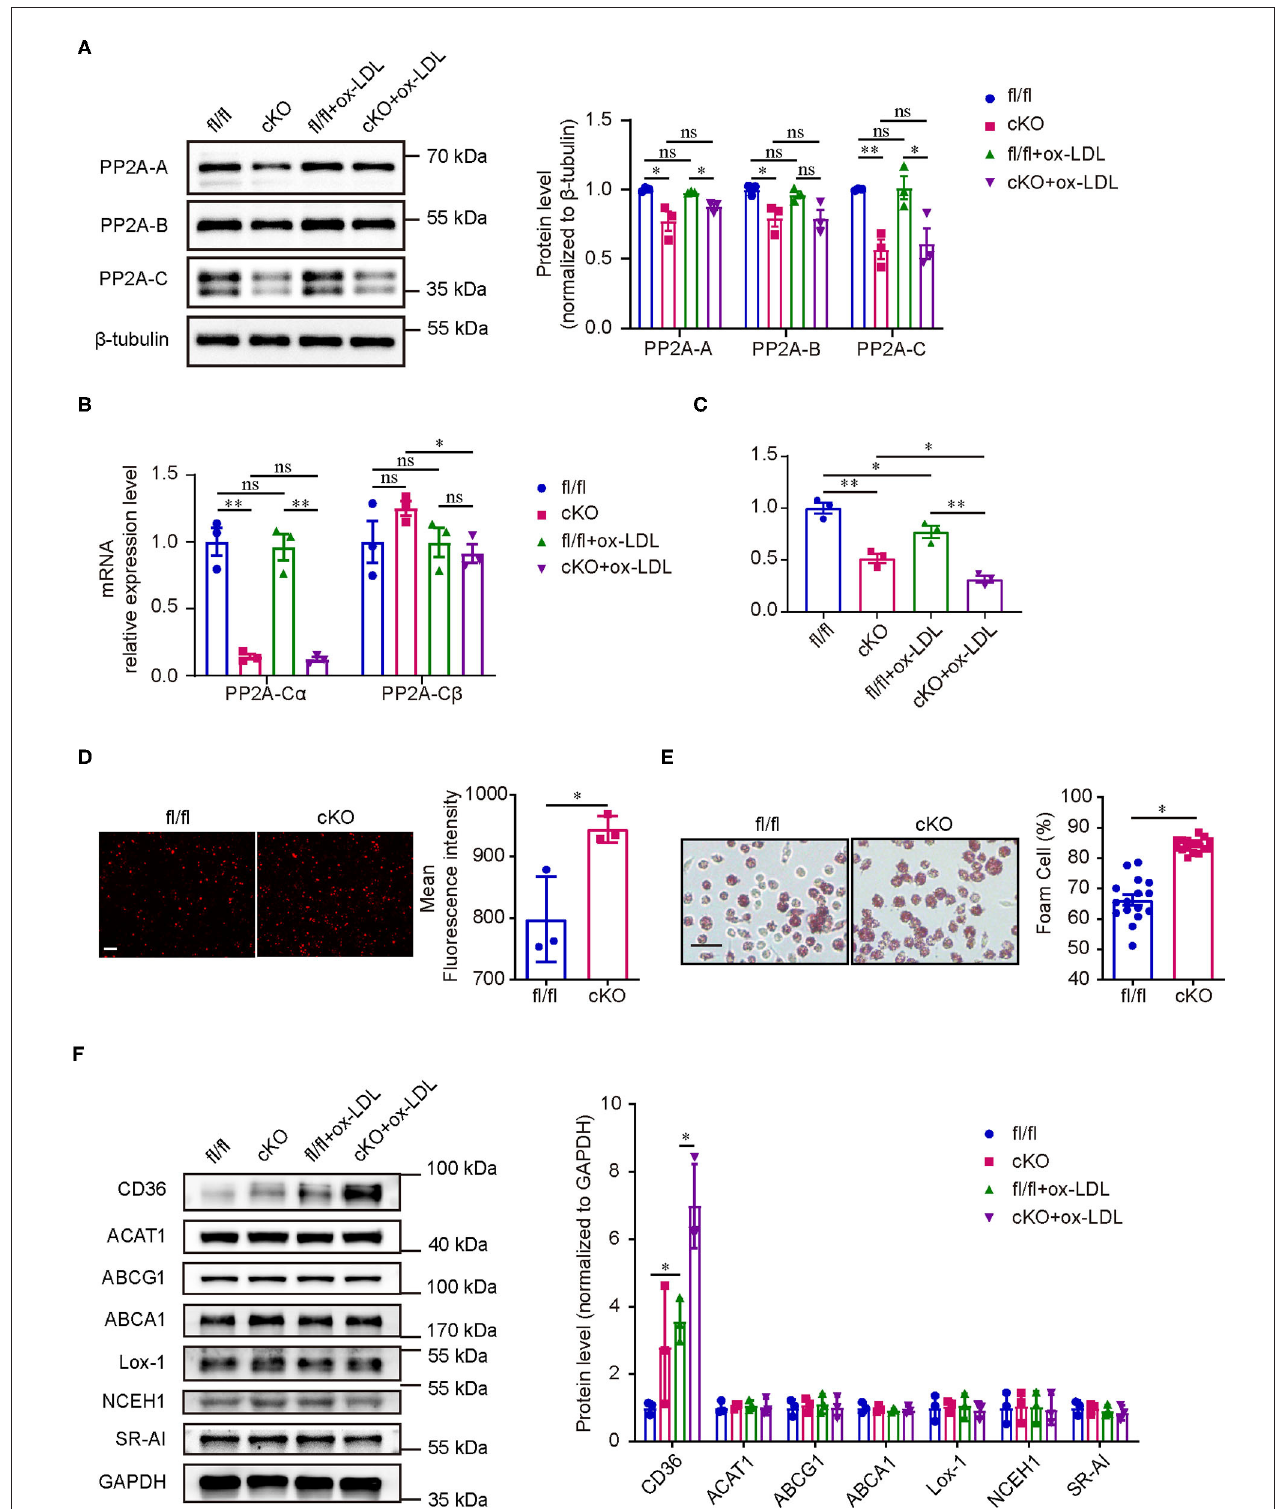
FIGURE 4 | PP2A deficiency in macrophages promoted foam cell formation. (A) Left panel: western blot of PP2A subunits in cKO and fl/fl macrophages treated with and without oxLDL for 24h. Right panel: quantification of western blot ( n = 3). (B) mRNA levels of PP2A-C α and PP2A-C β isoforms in cKO and fl/fl macrophages treated with and without oxLDL for 24h ( n = 3). (C) PP2A activity assay in cKO and fl/fl macrophages treated with and without oxLDL for 24h ( n = 3). (D) Left panel: